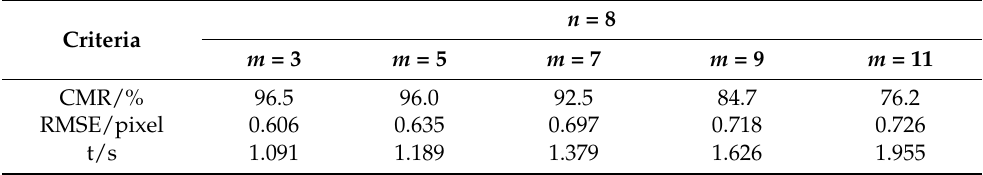
Table 7. The experimental results with a fixed n and different parameter settings of m